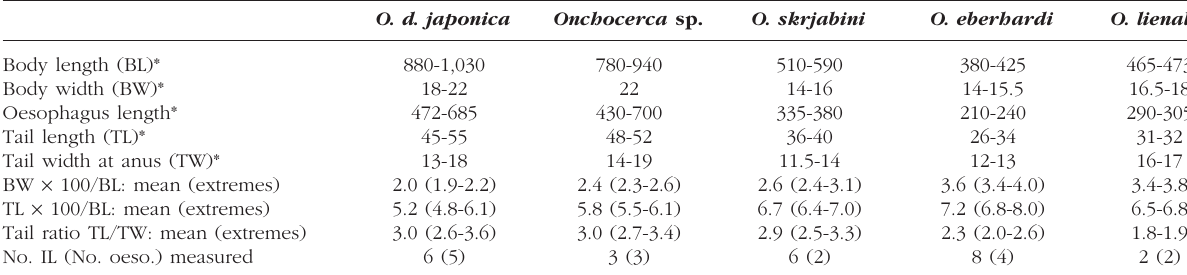
Table VI. – Infective larvae of Onchocerca spp. obtained from Simulium spp. injected with microfilariae in Oita,